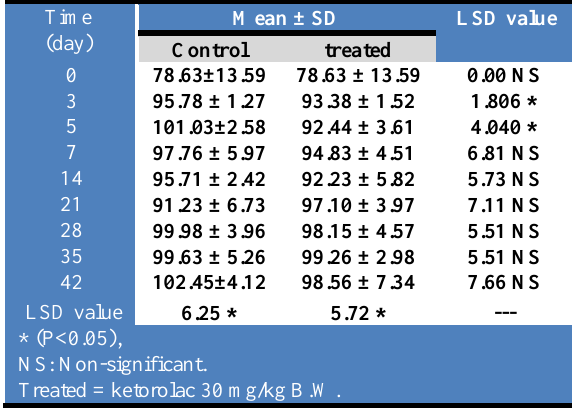
Table, 6: Shows MCV (fL) in control and ketorolac treated